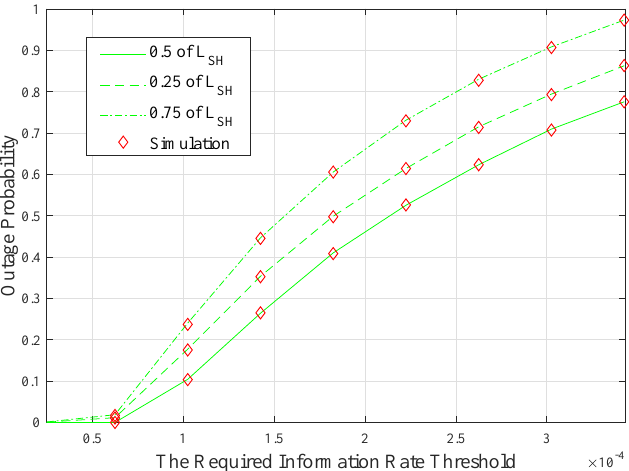
Figure 8. Average outage probability performance of the cooperative configurations as a function of the required information rate threshold